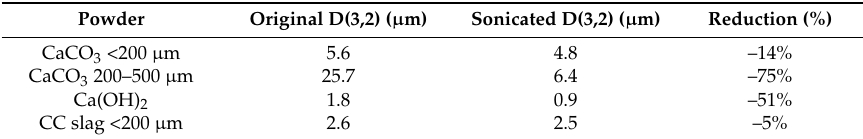
Table 1. Particle size reduction by sonication, expressed as Sauter mean diameter [11]. Re-used with permission from John Wiley and Sons